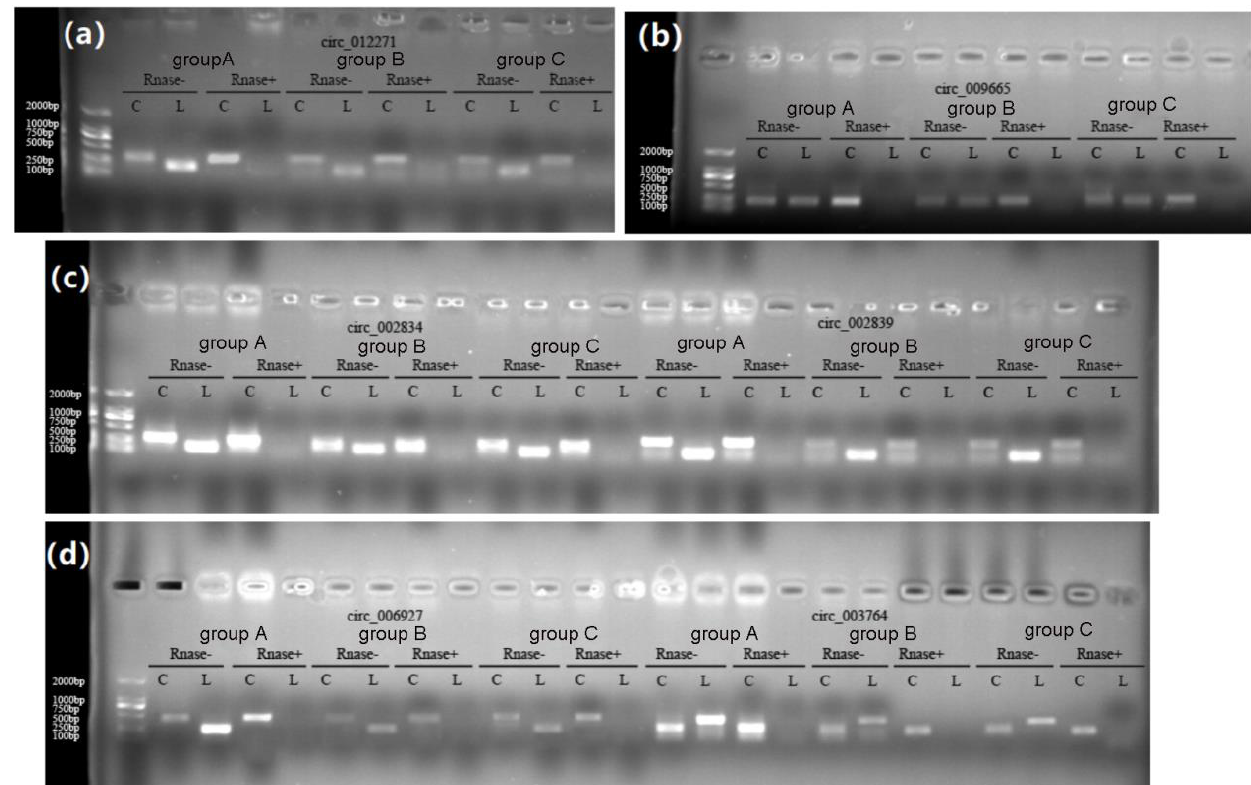
Figure 8. Electrophoresis of circRNA sequences at the loop junction site. ( a – d ) Electrophoresis of circ_012271, circ_009665, circ_002834, circ_002839, circ_006927, circ_003764 sequences at the loop junction site, respectively.